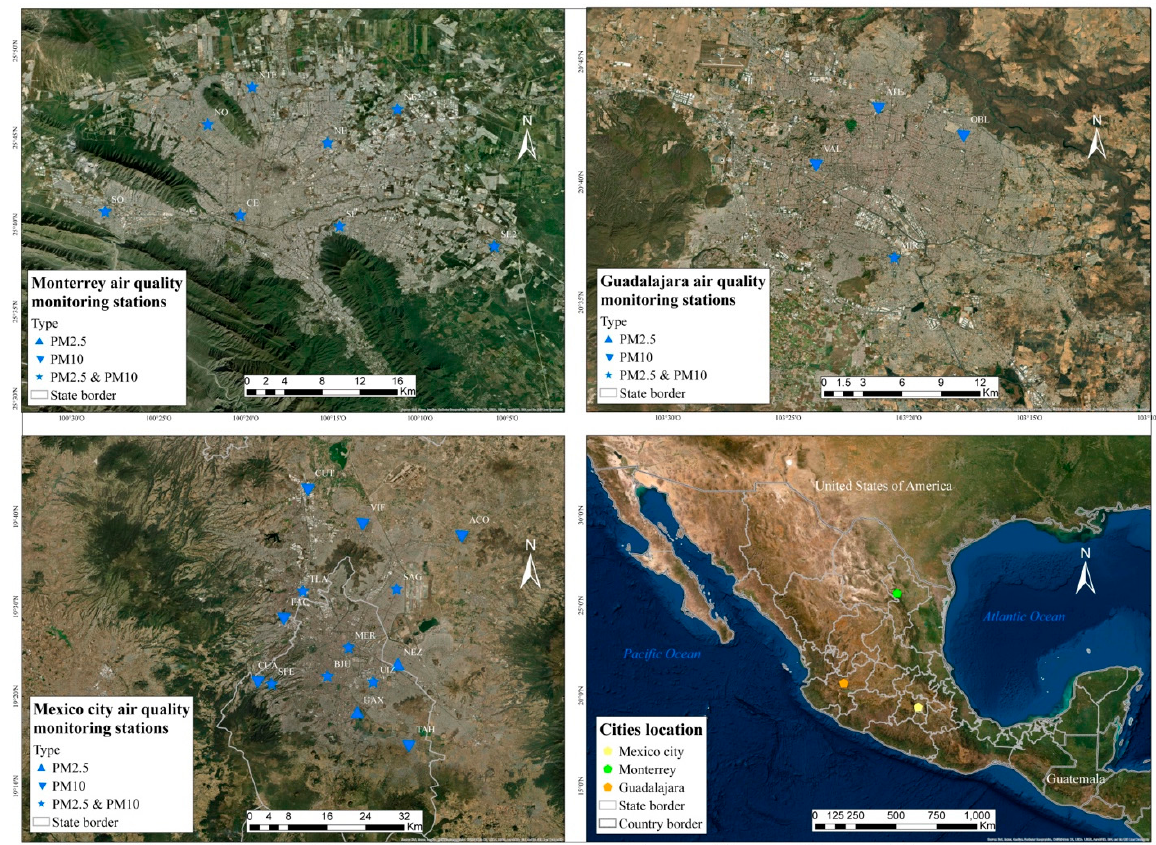
Figure 1. Locations of Guadalajara, Monterrey, and Mexico City, and locations of the stations used in each city. The light grey areas are urban areas, whereas dark green areas are forest and/or mountains. All stations report meteorological and PM data. See Table A1 in the Appendix A for more information about the stations.